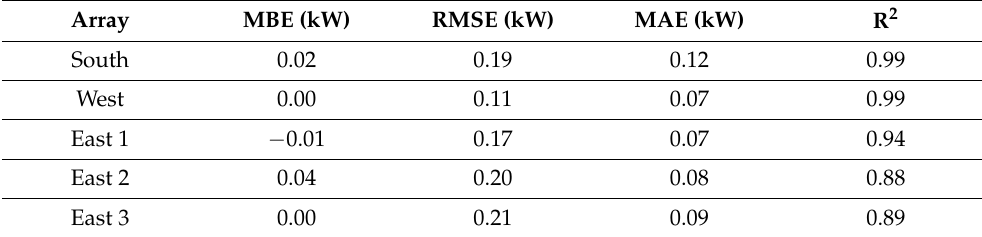
Figure 8. ANN modeling results of the BIPV monitored data for a few illustrative days. Table 2. Error metrics in the assessment of the ANN